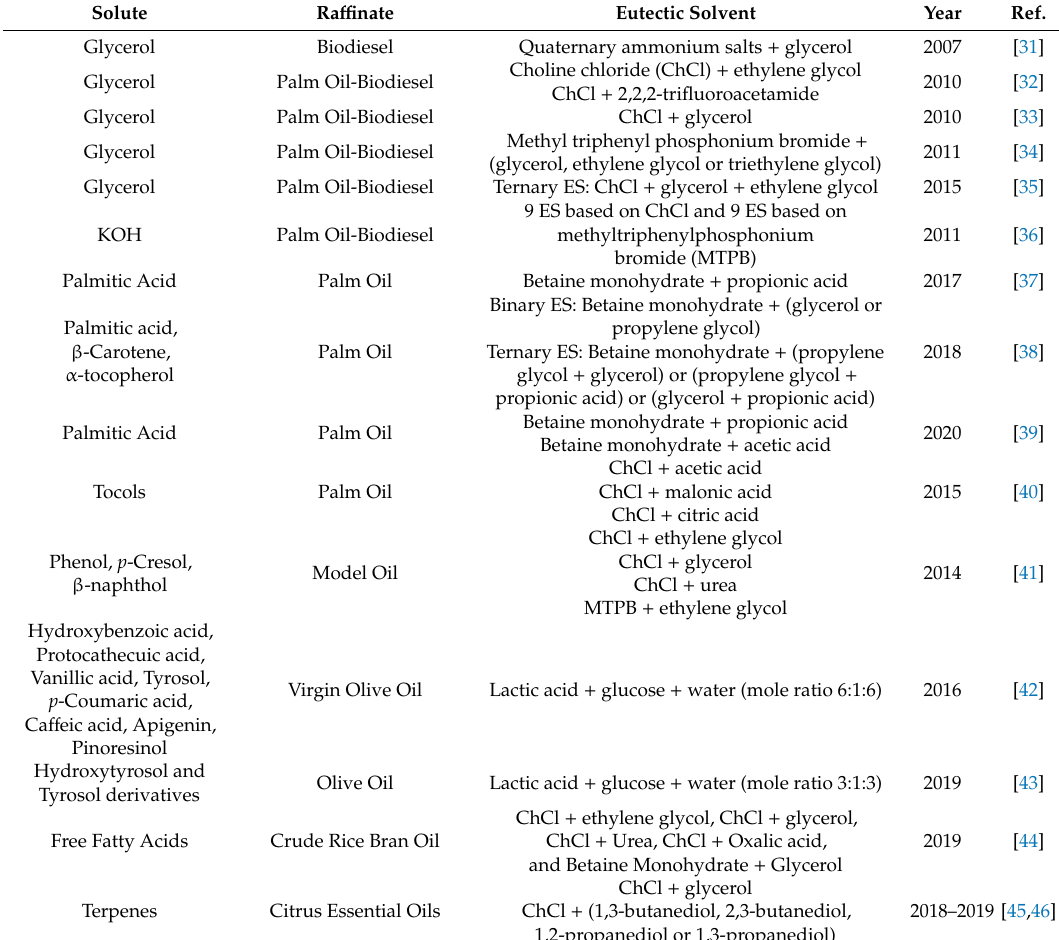
Table 1. Eutectic Solvents (ES) in the Liquid–liquid Extraction from Vegetable Oils and Biodiesel. Solute Ra ffi nate Eutectic Solvent Ref. Glycerol